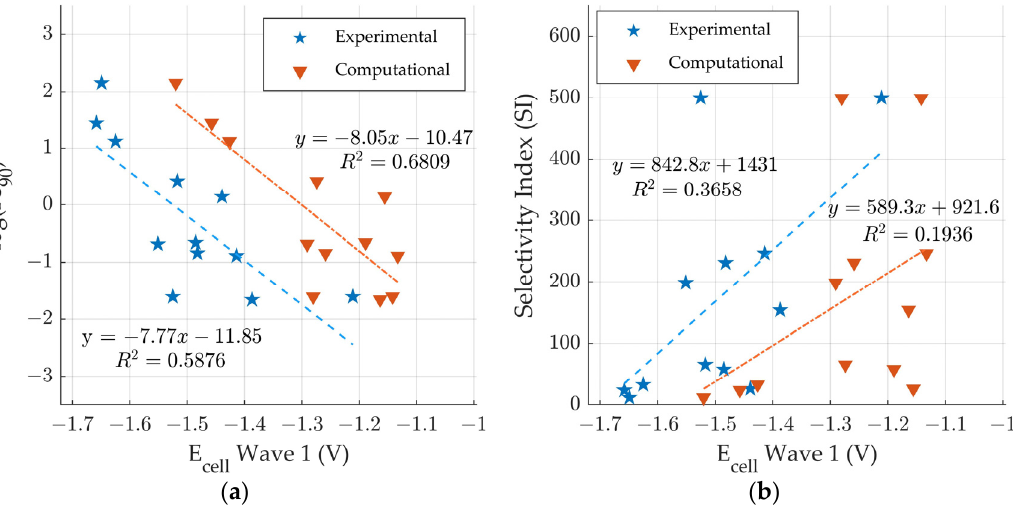
Figure 6. Comparison of computationally predicted and experimental electrochemical cell potentials [18] vs. anti-tuberculosis activity for compounds 1–12 [18]. ( a ) logIC90 vs wave 1 and ( b ) SI vs wave 1.